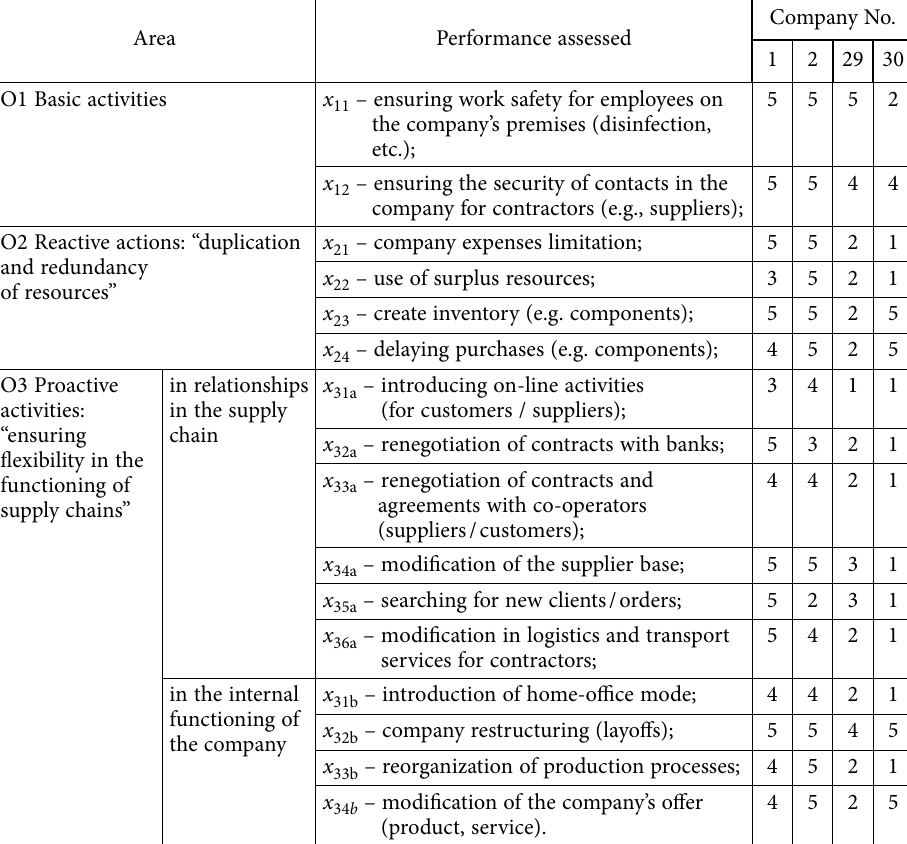
Company No. 1 2 29 30